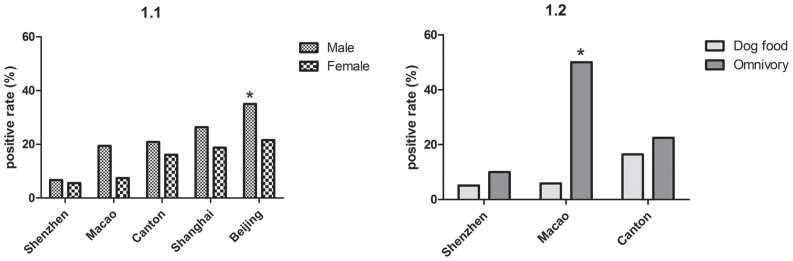
Prevalence of HEV among pet dogs in different cities according to gender and food.1.1 Anti-HEV of dog serum for different genders; 1.2 Anti-HEV of dog serum for different eating habits. Statistical analyses performed in Fig. 1.1 and 1.2 separately divide by gender and food source for each city were indicated on the figure with an asterisk (*); *, statistically significant and P value <0.01.